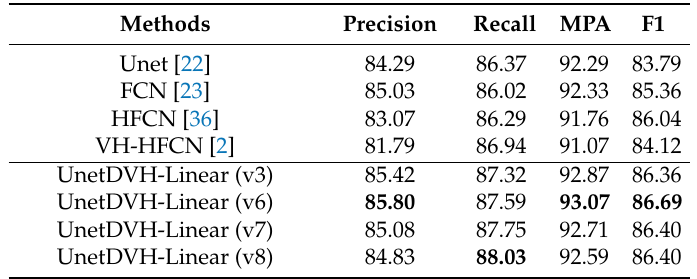
Table 7. Compared the DVH and v9h9 block on the SS test dataset (%).